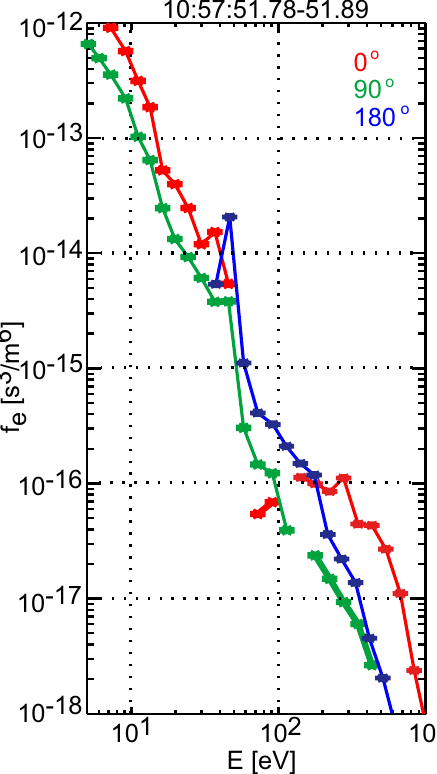
Figure 2 Fig. 2. Electron energy distribution function obtained at the den- sity dip on the magnetospheric side of the magnetopause from 10:57:51.78 to 51.89UT by the PEACE instrument. Two compo- nents of accelerated electrons are detected. One is the hot beam (red) in the parallel direction (away from the X-line) of a few hun- dreds eV. The electron beam energy corresponds roughly to the local electron Alfv´en velocity. The other is the colder population (blue) in the anti-parallel (into the X-line)